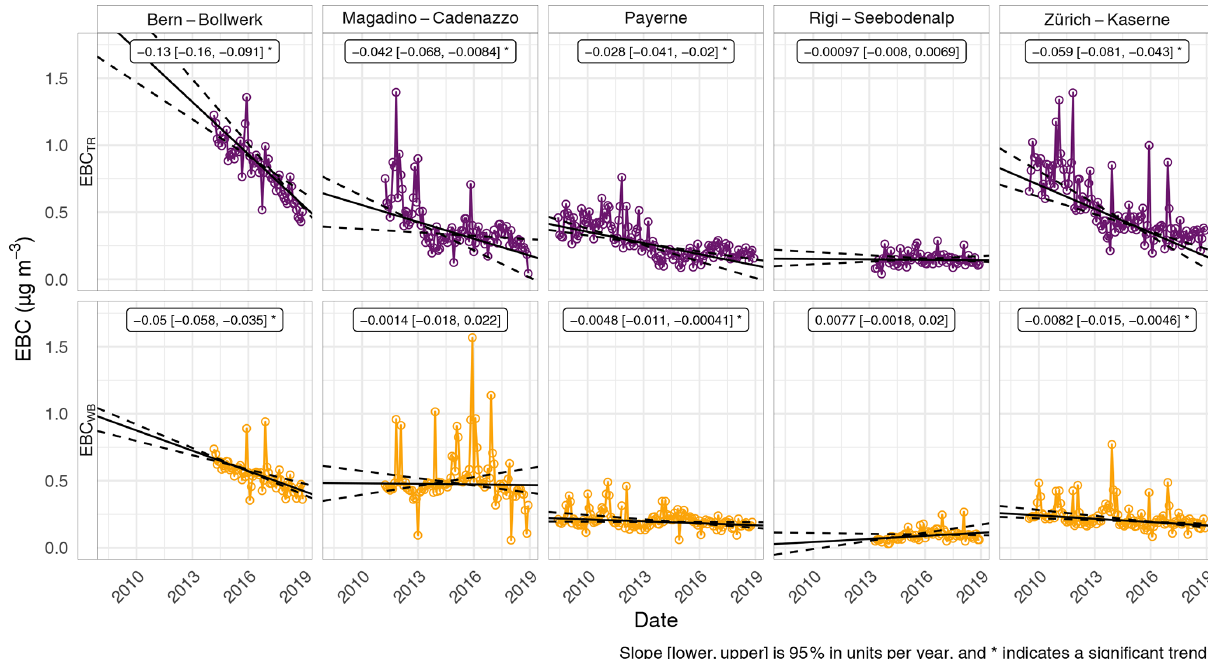
Figure 9. Deseasonalised trends of EBC TR and EBC WB at five EBC monitoring sites in Switzerland between 2008 and 2018. Slope is the 95% CI. CI: confidence interval.